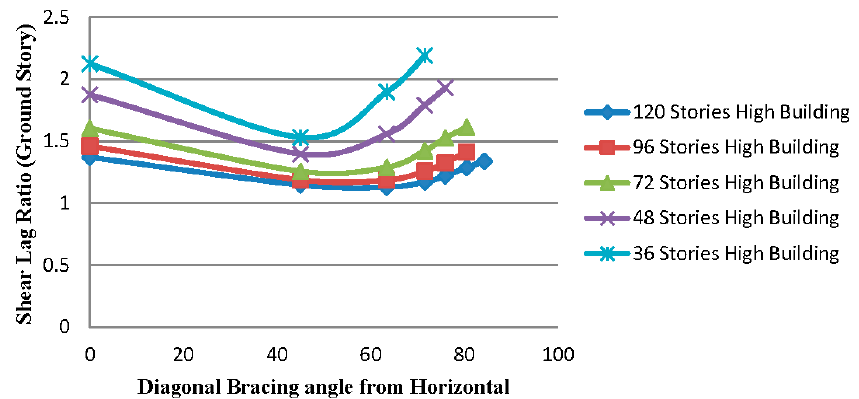
Figure 17. Variation of shear lag with varying angle of bracing system for buildings of Model 3.